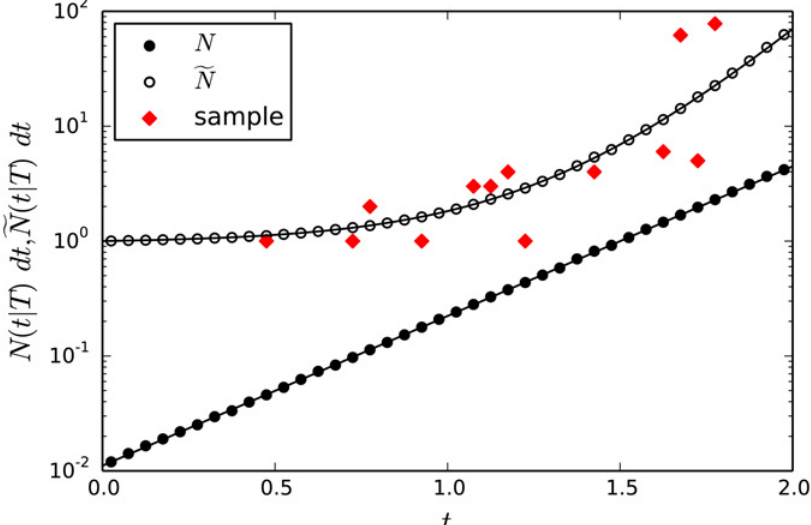
Fig 4. The benefit to useÑ( t j T ) instead of N ( t j T ) to estimate the parameters of the evolution process in a case of a small dataset. In this plot T = 1, λ = 11, μ = 5, σ = 0.01 and dt = 0.005. After average over many samples ( S * 10 6 in this particular case) empirical averages of both N ( t j T ) (full circles) and ~ N ð t j T Þ (open circles) converge nicely to the analytic formulas. The last are given in Equations (14) and (27), respectively, and are denoted by the lines in the figure (see the legend). However, for a single random tree, S = 1, the values of N 1 ( t j T ) (diamonds) are highly dispersed (most intervals show zero counts and do not show up in the semilogarithmic plot), such that their fit to the analytic formula of N ( t j T ) is not expected to lead to a good estimation of the model ’ s parameters. In contrast, the values of N 1 ( t j T ), ignoring the bins where N 1 ( t j T ) = 0, are well distributed around ~ N ð t j T Þ , although in this example the tree possesses only 19 observed leaves, such that the data is very poor (only 171 pairs in